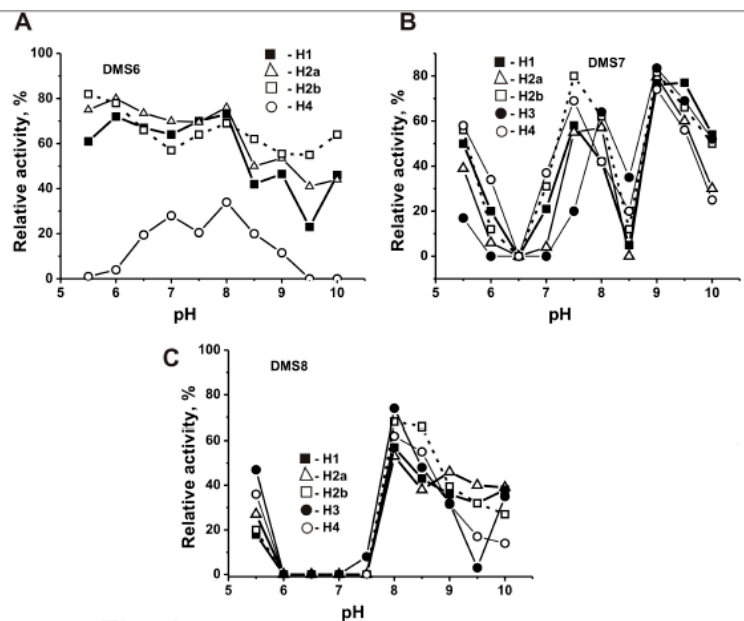
Figure 4. The pH dependence of the relative activity of three individual DMS6 ( A ), DMS7 ( B ), and DMS8 ( C ) preparations in the hydrolysis of the histones. The relative activity corresponding to a complete hydrolysis of every histone after 6 h of incubation in the presence of 0.33 µ M IgGs was taken for 100%. The average in the initial rate determination error from two experiments did not exceed 10–25%. Significant di ff erence ( p < 0.05; 0.0001–0.041) was revealed for the following data in